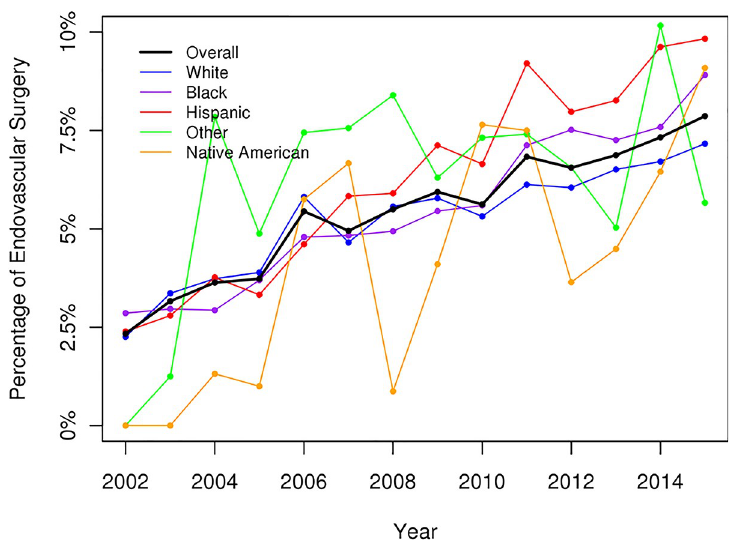
Fig 4. Endovascular procedure for diabetic foot infection (overall p <